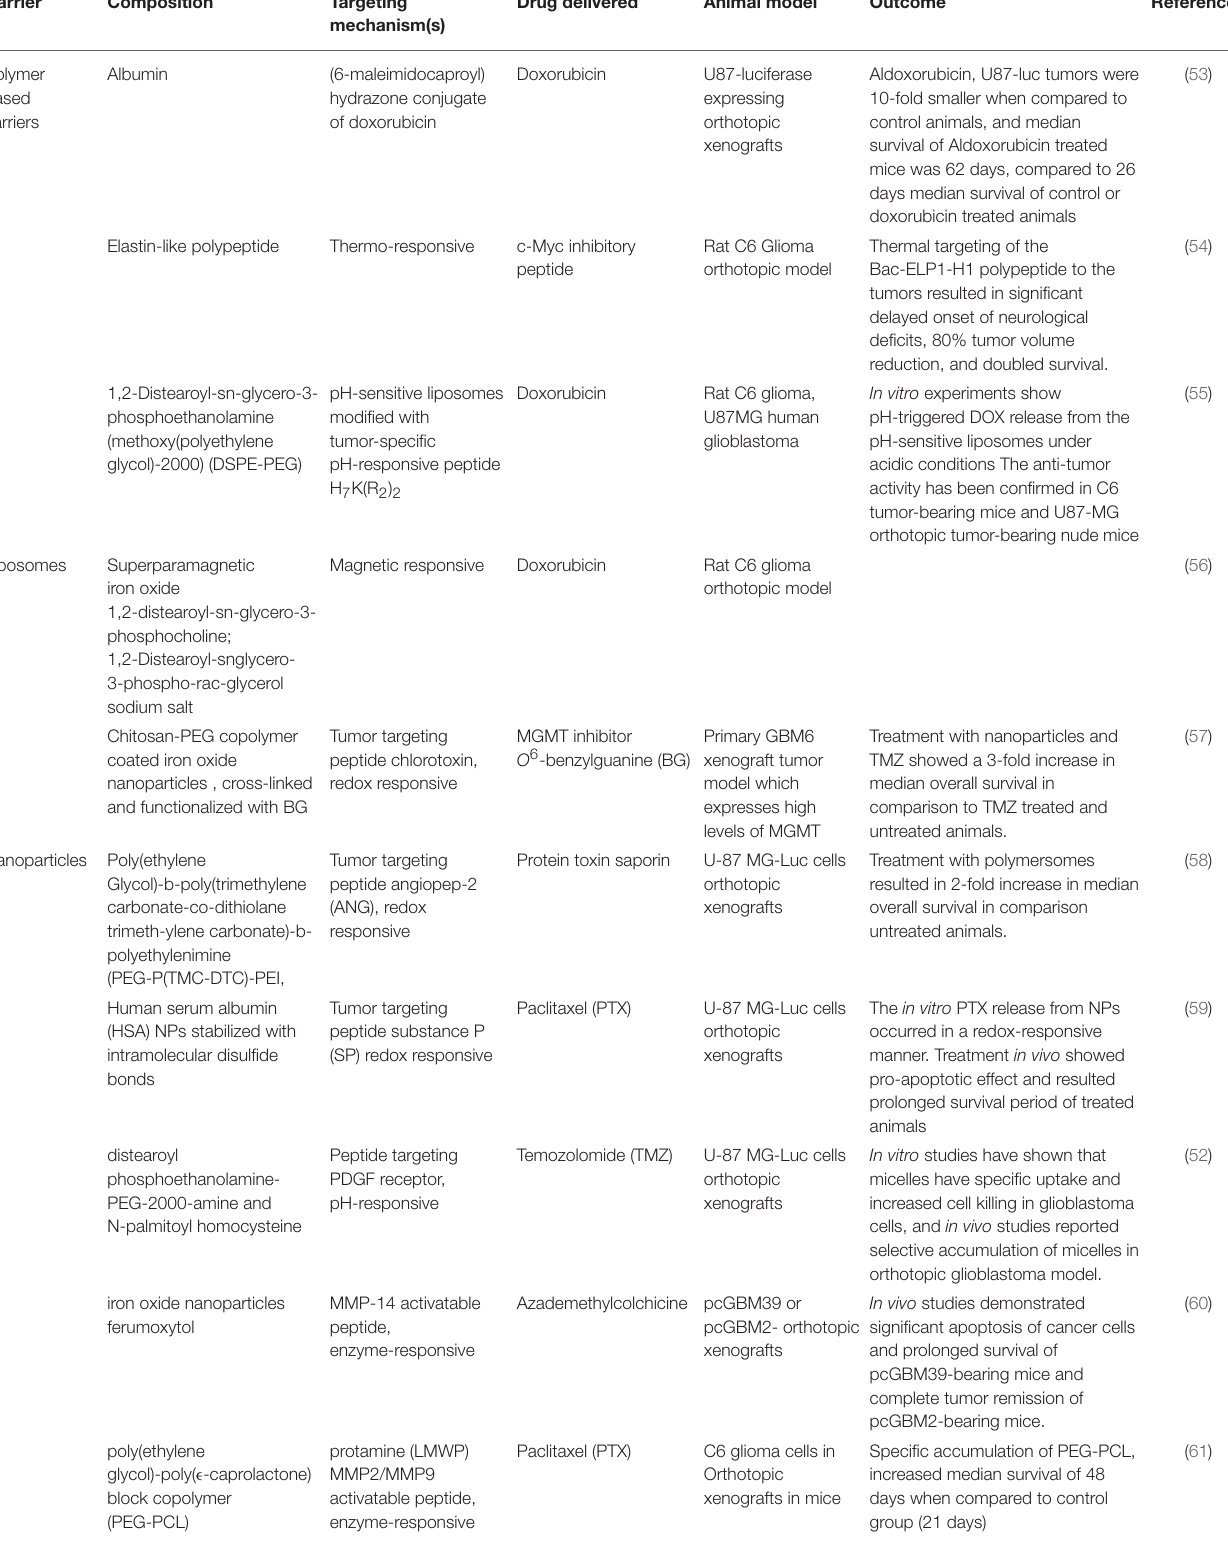
TABLE 2 | Stimuli responsive targeting macromolecules for GBM